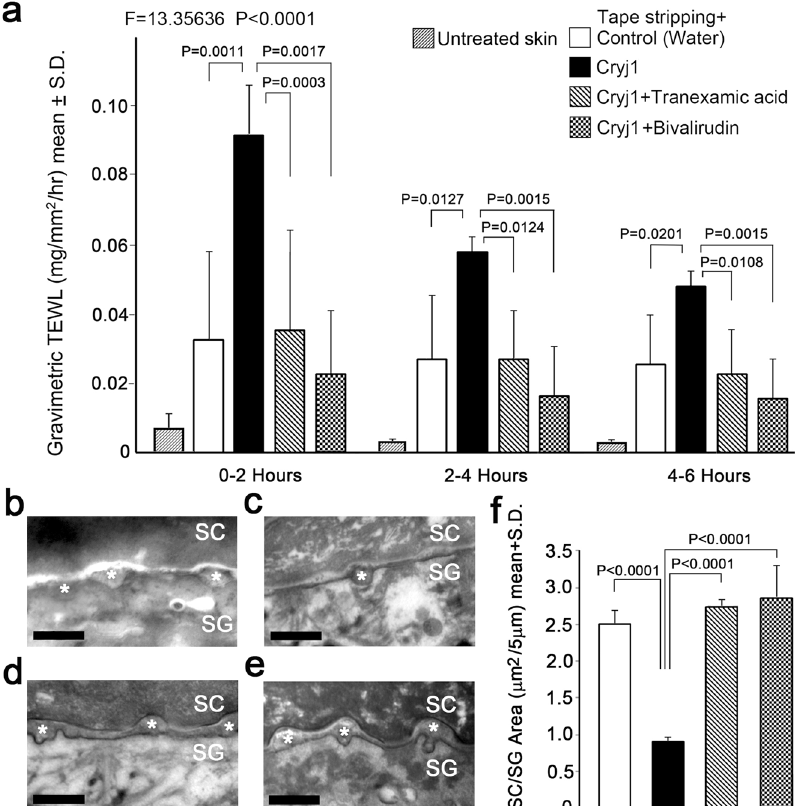
Figure 4. Evaluation of the water-impermeable barrier function of skin ex vivo , and electron-microscopic observation after application of Cry j1 with or without tranexamic acid or bivalirudin. ( a ) The vertical axis shows the amount of water loss during 0–2, 2–4 or 4–6 h after tape stripping (TS) (n = 5–6). Application of Cry j1 (1 μ g/ml) dramatically increased the water loss. The Cry j1-induced increase was significantly reduced by concomitant application of tranexamic acid (100 mM) or bivalirudin (1 μ g/ml). Bars and lines represent mean ± SD. ( b – f ) Electron-microscopic observation of ex vivo skin samples. ( b ) Tape-stripping (TS) 10 times and application of water. ( c ) TS and application of Cry j1 (1 μ g/ml). ( d ) TS and application of Cry j1 (1 μ g/ ml) and tranexamic acid (100 mM). ( e ) TS and application of Cry j1 (1 μ g/ml) and bivalirudin (1 μ g/ml).